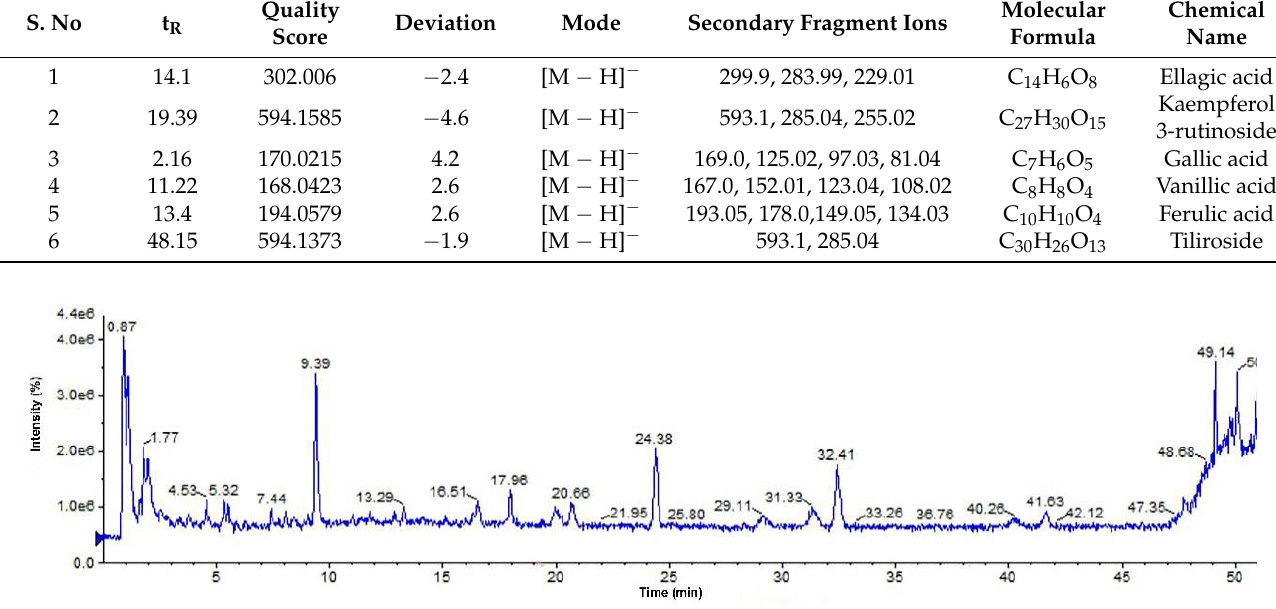
Figure 6. Total ion chromatogram of phenolic components in negative ion mode Table 1. UPLC-Q-TOF-MS ion fragments of six isolated phenolic compounds